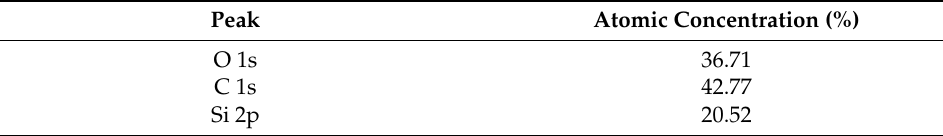
Table 2. Results of atomic concentration calculations.